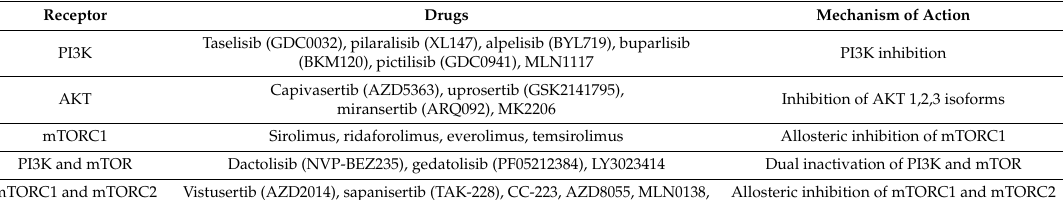
Table 3. PI3K–AKT–mTOR pathway